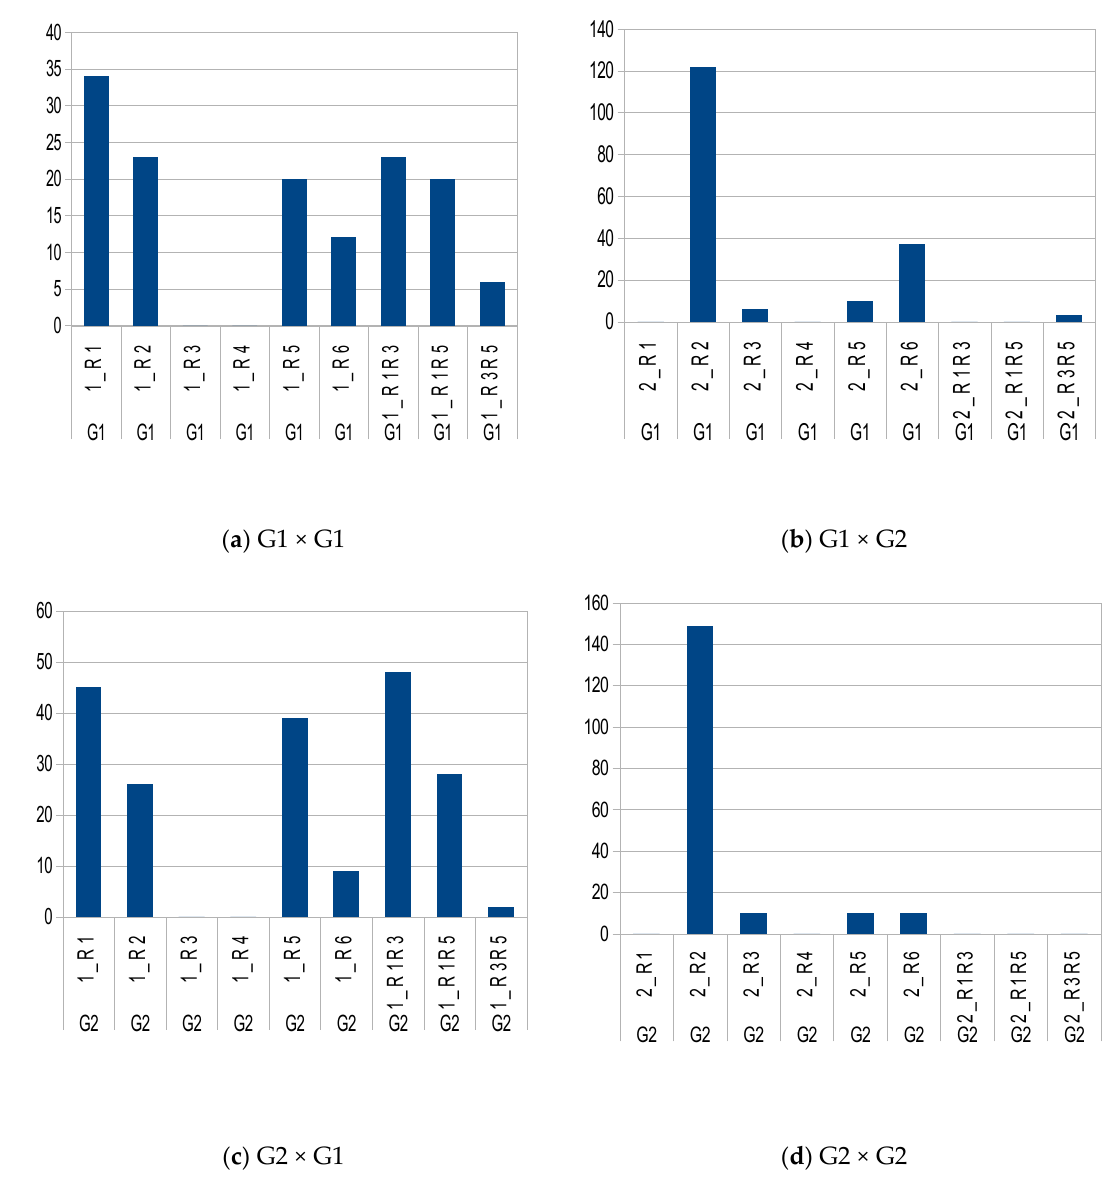
Figure 2. Number of crosses examined from the literature for pairwise combinations of varieties belonging to the frame of DSI to ( b ) G1 × G2 and ( c ) G2 × G1 expected with fruit in accordance with DSI and ( a ) G1 × G1 and ( d ) G2 × G2 expected without fruit, but that showed fruit, which sustained degradation of the S ‐ determinants (DS ‐ D).